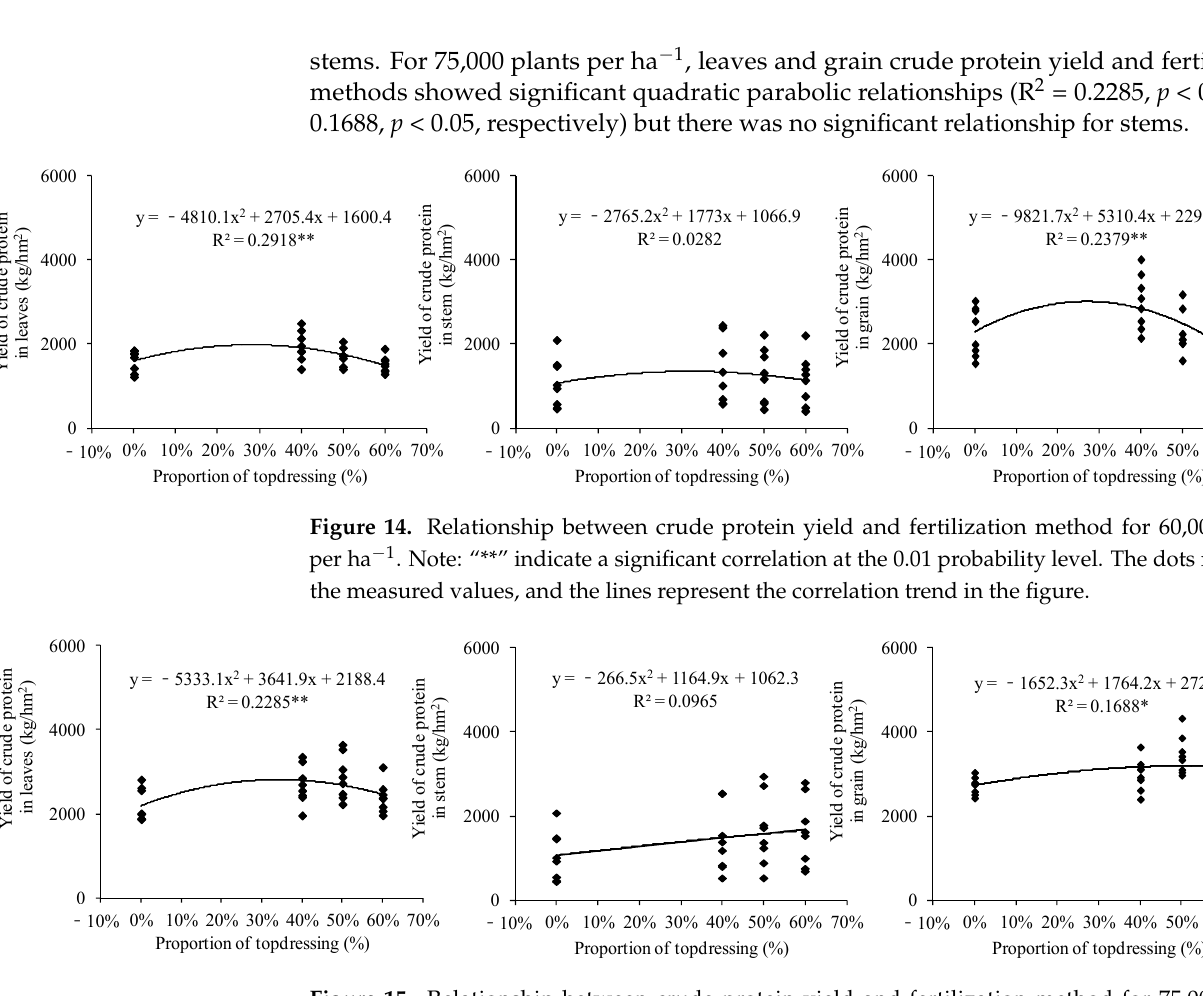
indicate a significant correlation at the 0.01 probability level. The dots represent the measured val-